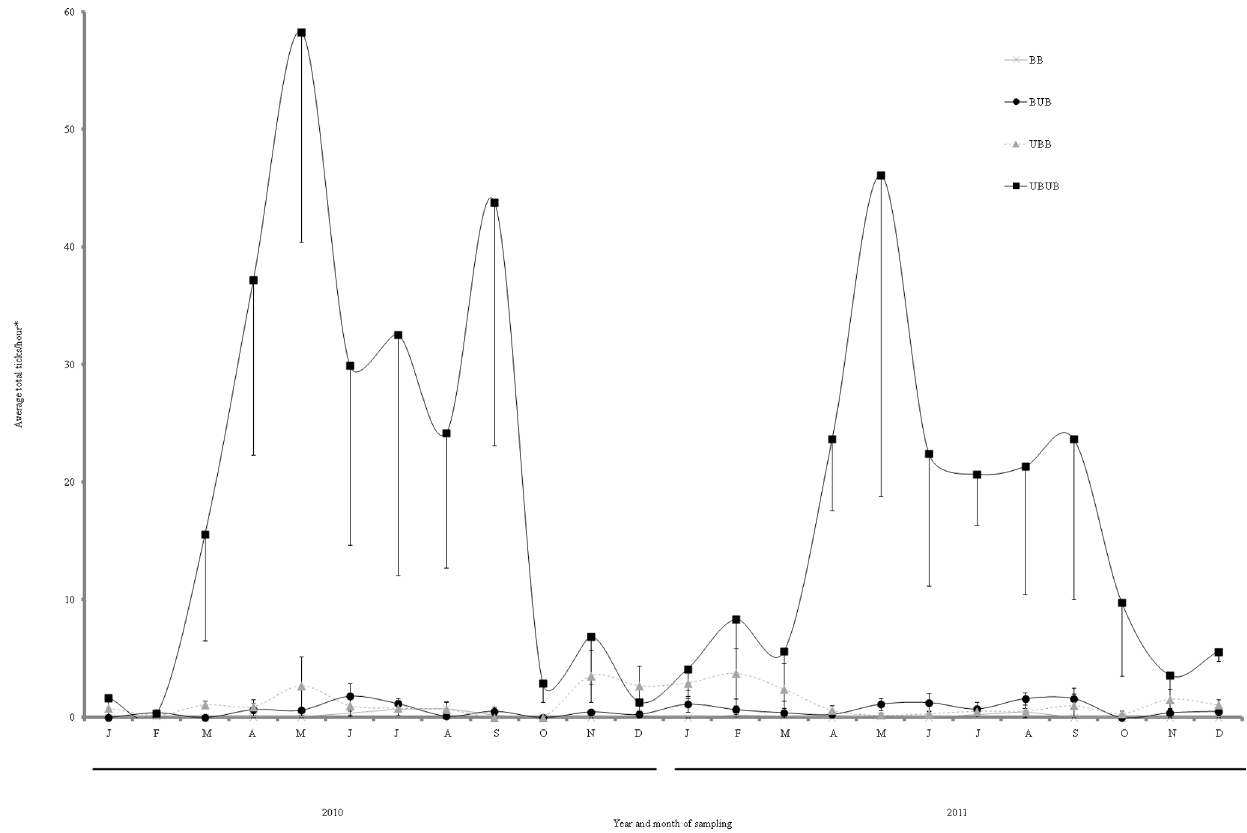
Figure 2. Effects of long-term prescribed burning on tick abundance at all study plots. *One clutch of larvae was counted as one tick.